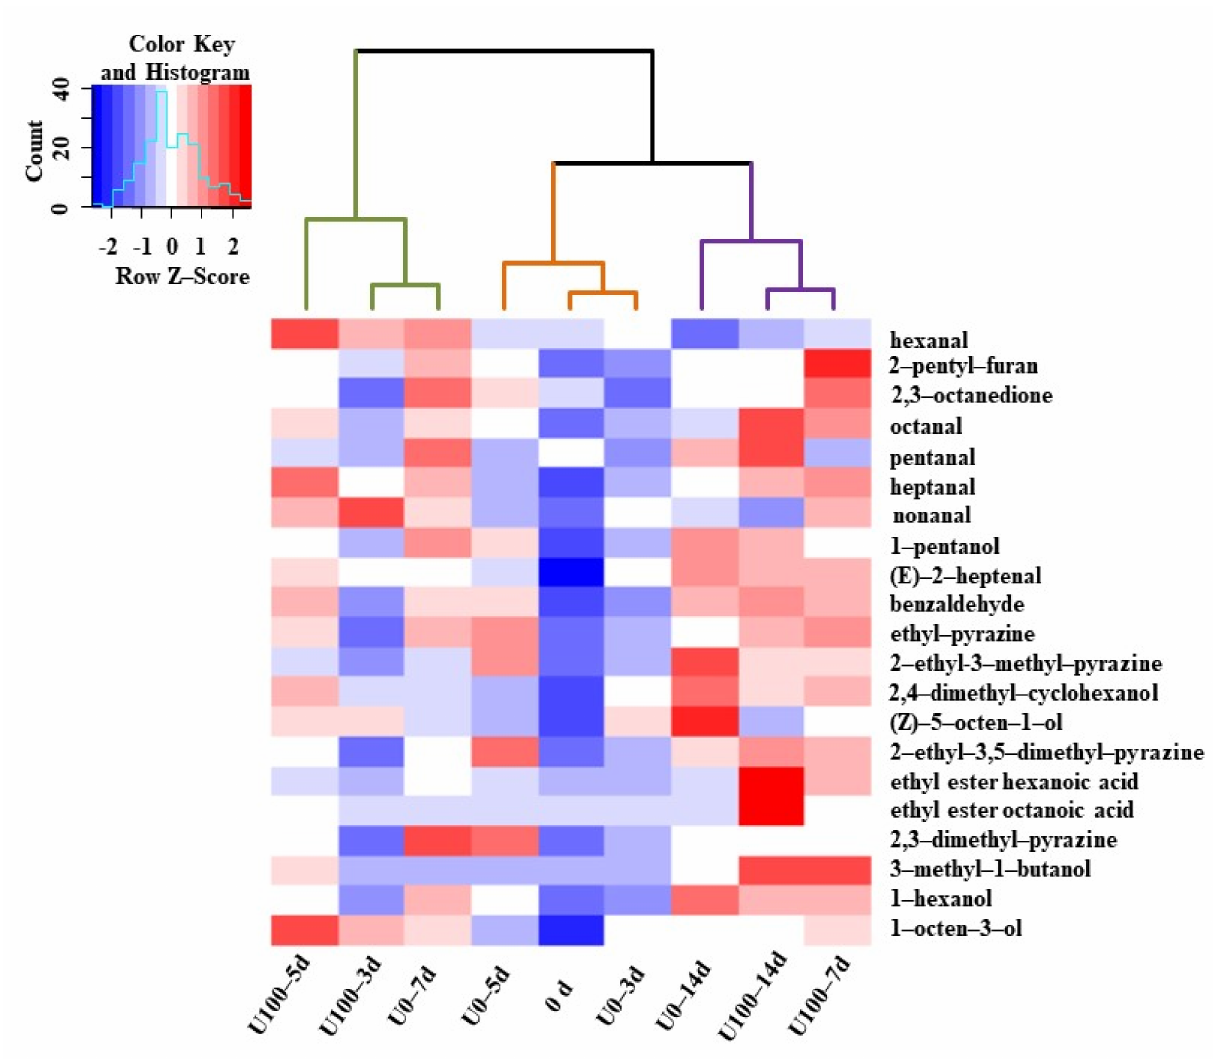
Figure 3. The heat map of volatile compositions during the fermentation Suanzhayu samples without (U0) and with (U100) lipase. The colors indicate low ( blue ) to high ( red